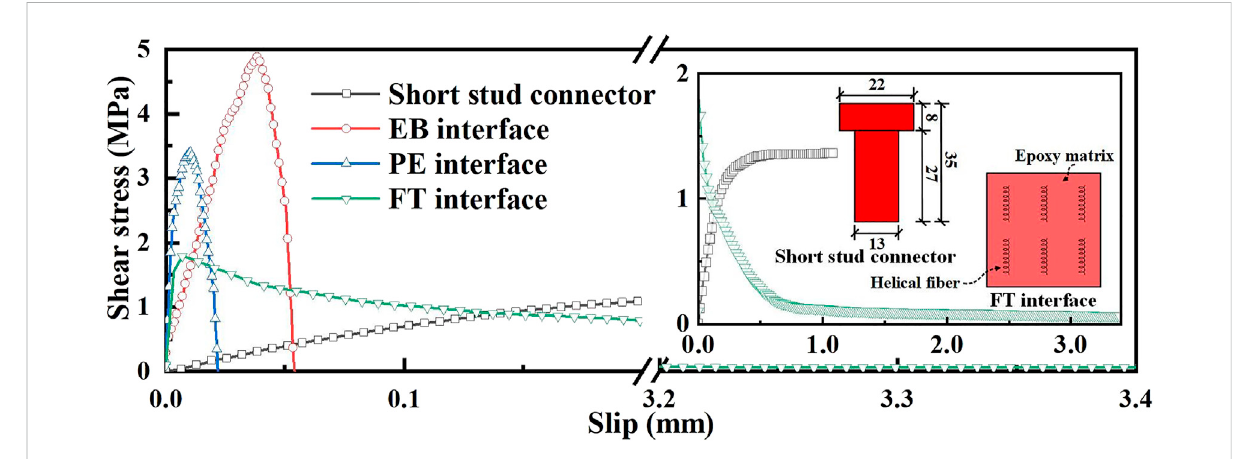
FIGURE 3 Comparison of shear stress-slip curves between short stud connector and